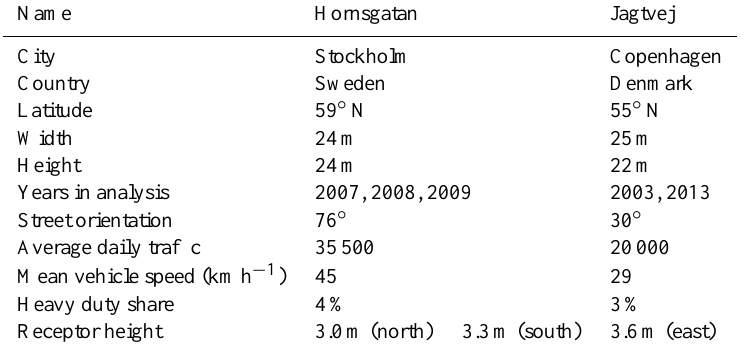
Table 1. Overview of the properties of the two street canyons used for validation of the dispersion schemes in the study. There is a measure- ment station (receptor) at each side of the street in Hornsgatan, but only one measurement station on the east side of Jagtvej. Name Hornsgatan Jagtvej City Stockholm Copenhagen Sweden